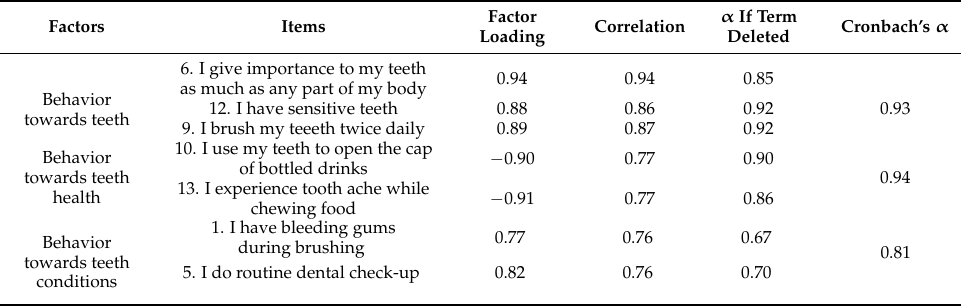
Table 5. Result of EFA for behavior-based